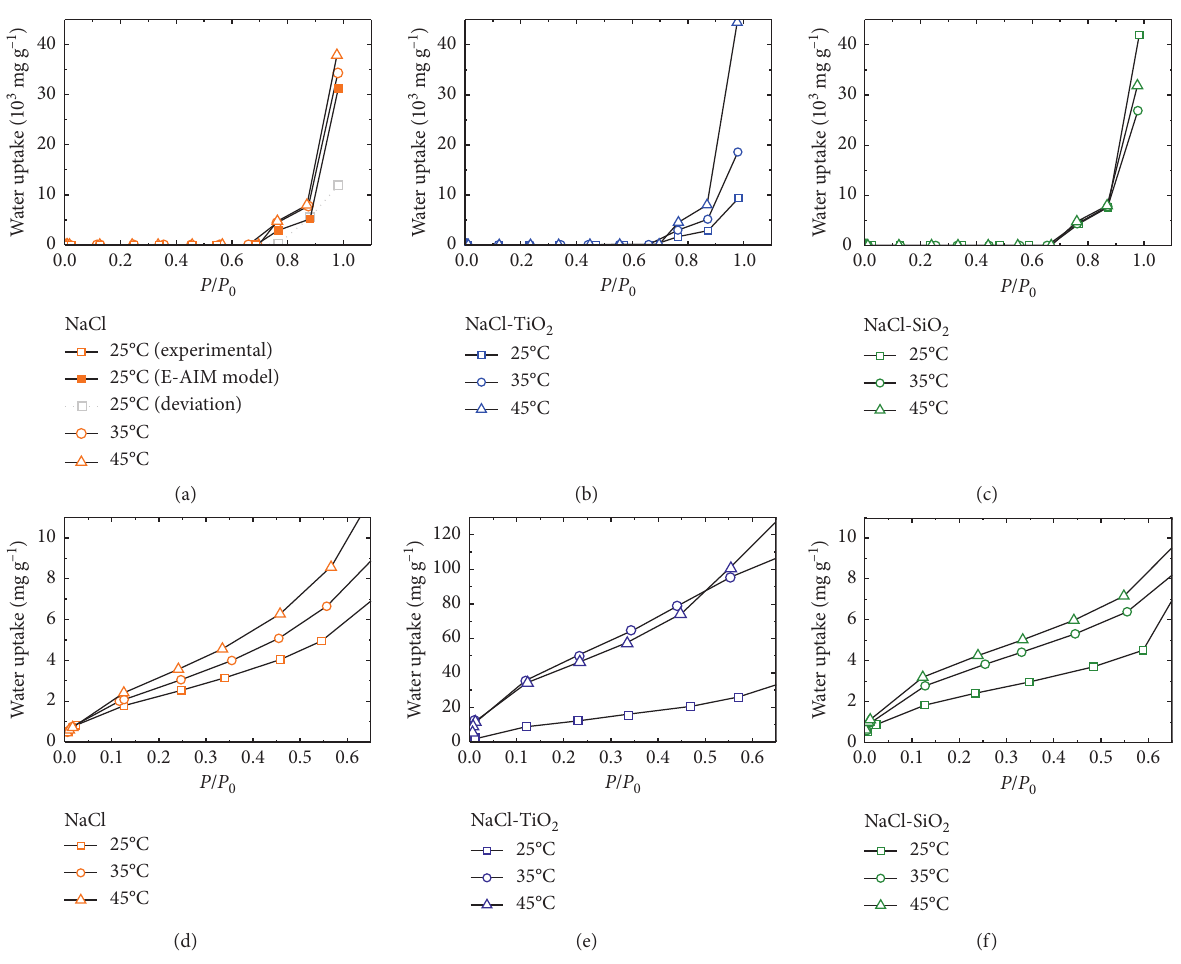
Figure 9: Water sorption analysis with isotherms at 25 ° C, 35 ° C, and 45 ° C: (a) and (d) for NaCl; (b) and (e) for NaCl-TiO NaCl-SiO 2 , at relative pressure (0 to 1) top and an inset for low values of relative pressure (0 to 0.6) bottom. The isotherm of NaCl at 25 ° C shows a deviation obtained experimentally after the hygroscopic point and the correction as per the E-AIM model.